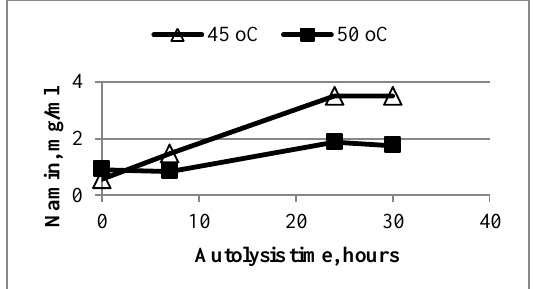
Fig. 3. The α-amino nitrogen content of Yeast extract during autolysis